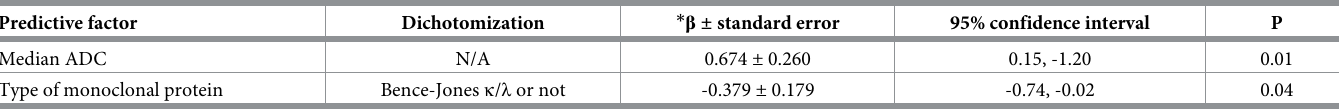
Note. Values represent mean ± standard